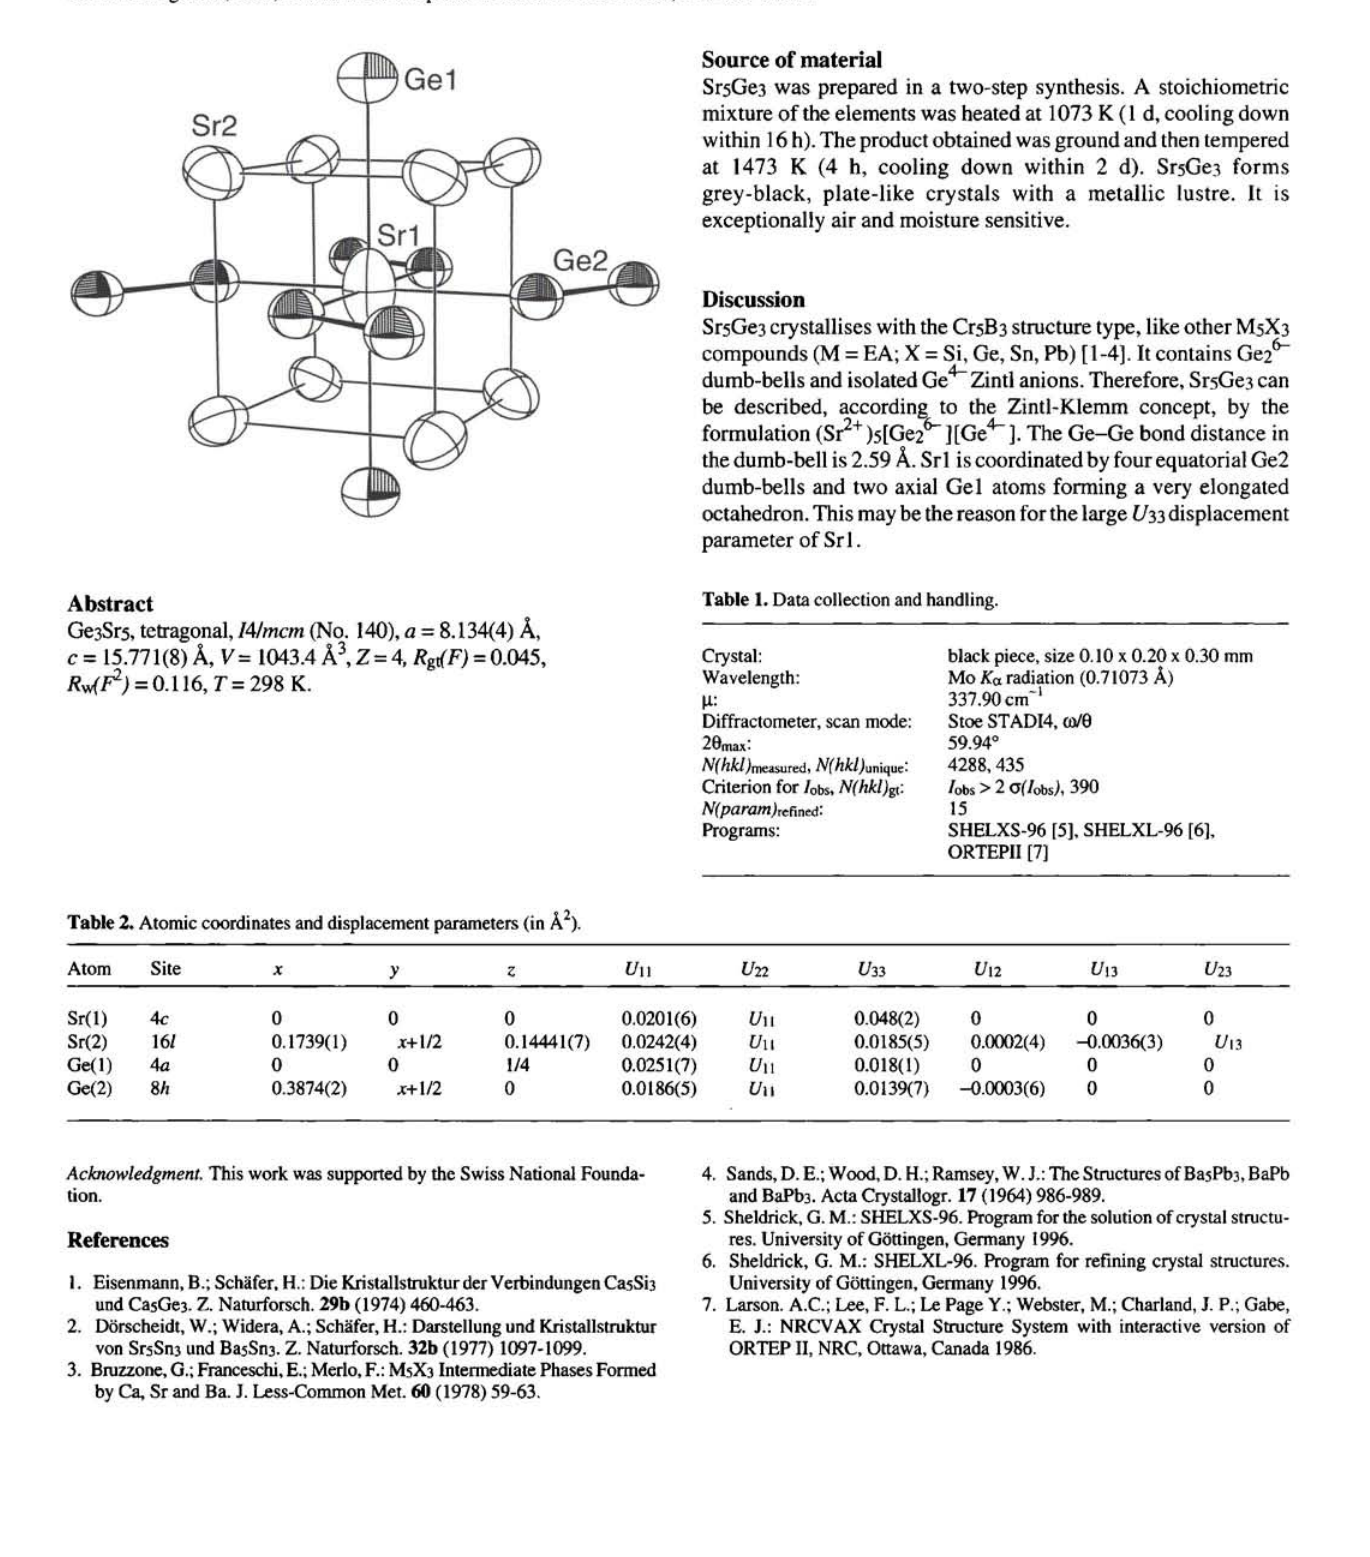
Table 2. Atomic coordinates and displacement parameters (in Â 2 ).